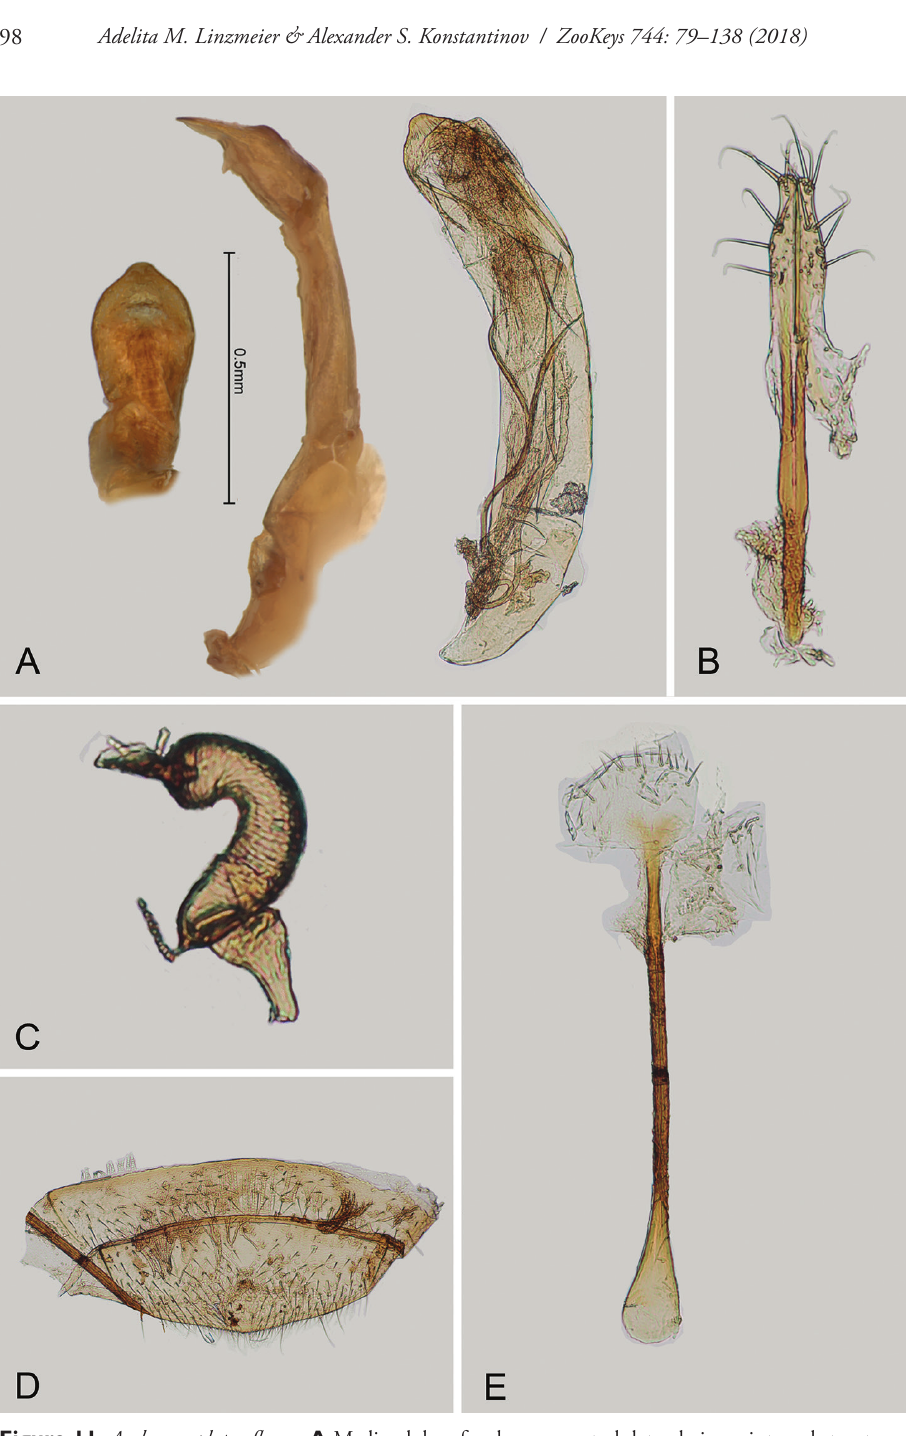
Figure 11. Andersonoplatus flavus . A Median lobe of aedeagus, ventral, lateral views, internal structures under compound scope B Vaginal palpi C Spermatheca D Last abdominal sternite of female E